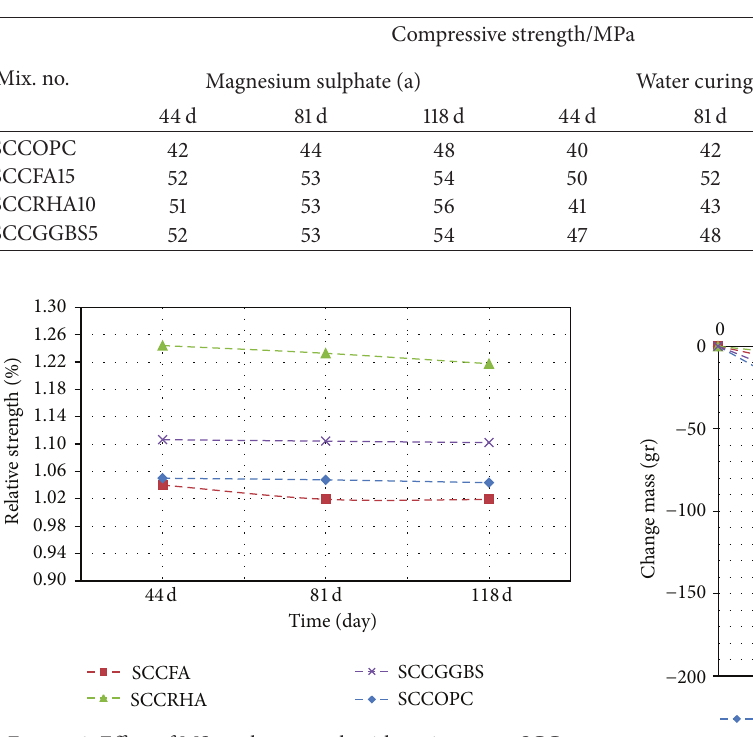
Table 5: Effect of MS on the strength with curing SCC.